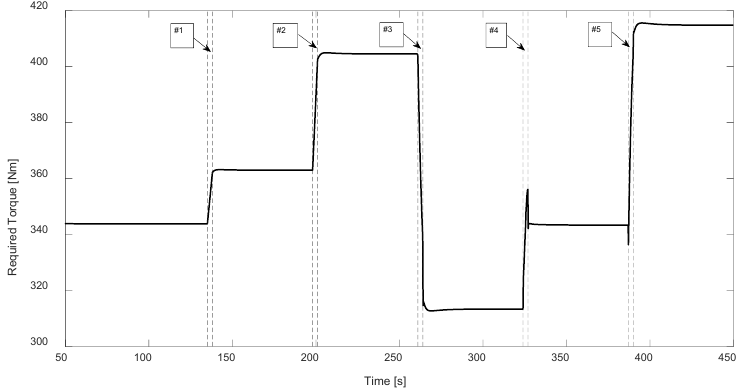
Figure 7. Torque required by rotor shaft (vertical dashed lines correspond to transient start and